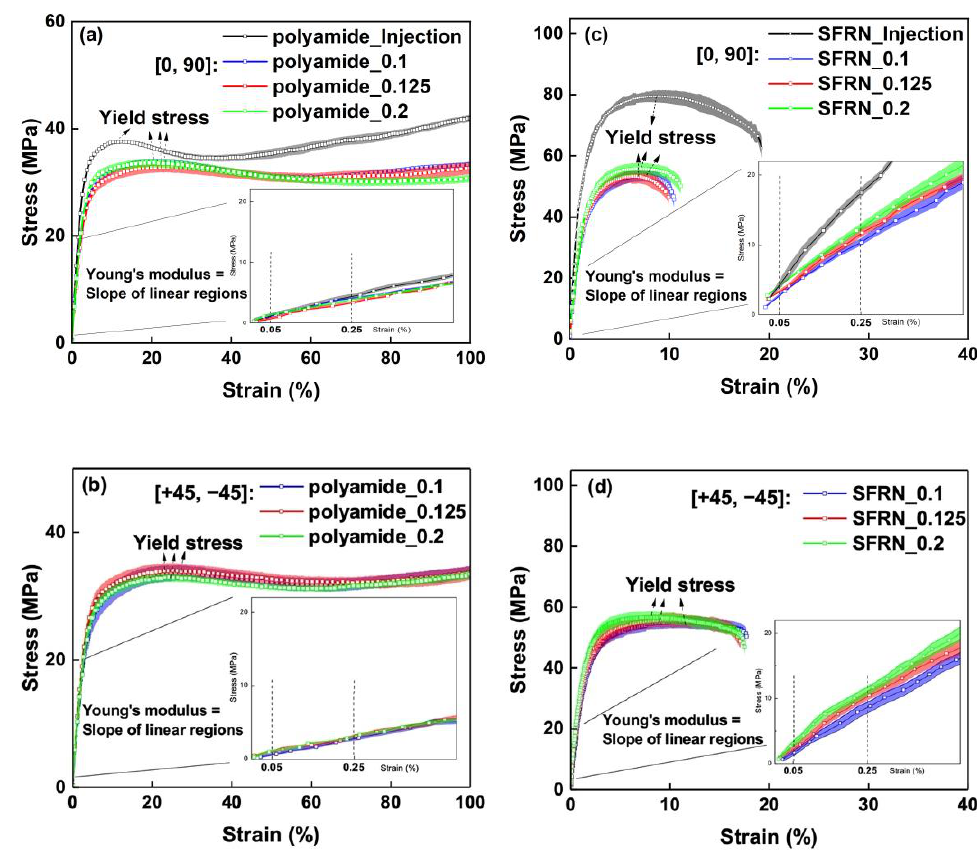
Figure 7. The strain–stress curves of the fabricated samples with 3 mm thick: ( a ) injection-moulded and [0, 90] polyamide; ( b ) [+45, − 45] polyamide; ( c ) injection-moulded and [0, 90] SFRN; ( d ) [+45, − 45] SFRN. Table 4. The tensile properties of the printed and injection-moulded samples. Polyamide SFRN Thick Layer Thickness (mm) (mm) Raster